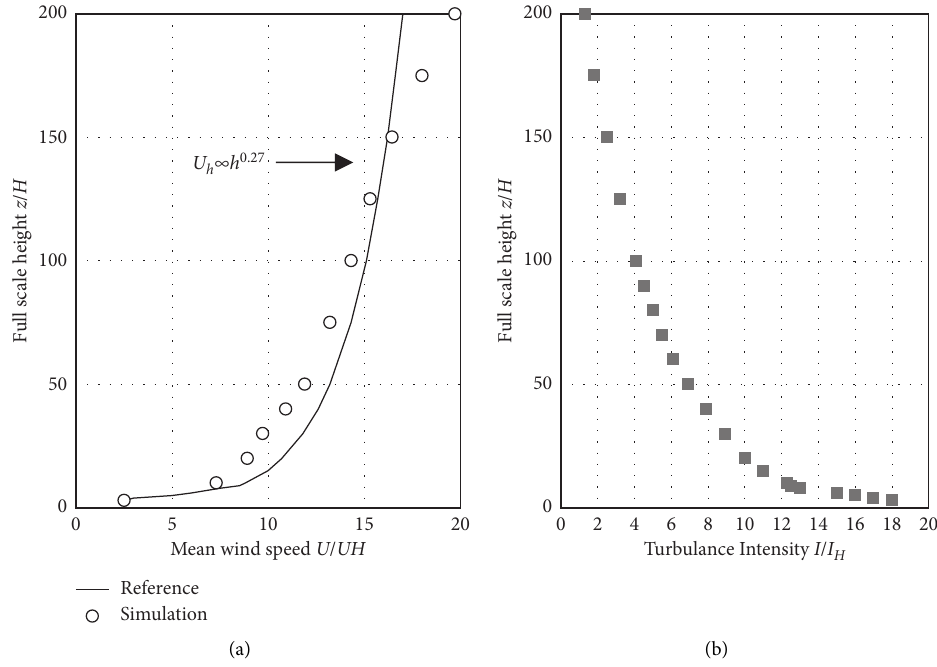
Figure 3: (a) Wind velocity profiles. (b) Turbulent